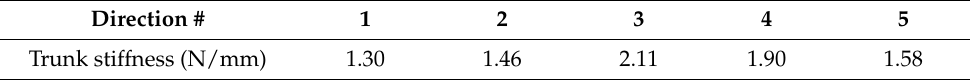
Figure 1. Directions (from 1 to 5) of displacement perturbations. The five among the eight directions retained from [18], considering sagittal symmetry. Table 1. Average experimental trunk stiffness [18] reduced to five